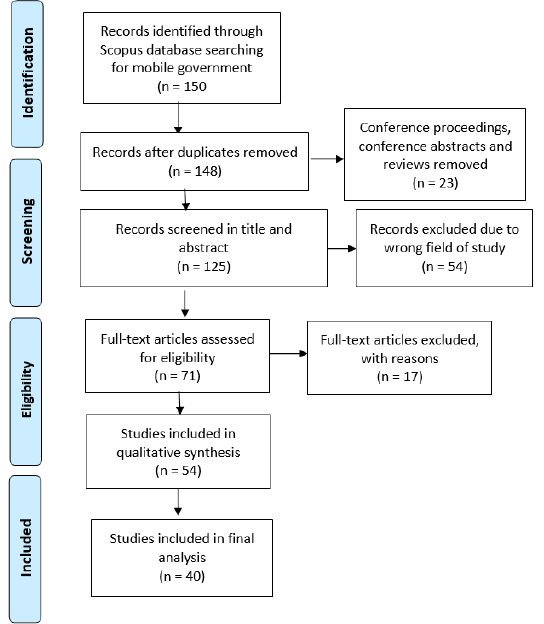
Fig. 1. Literature search and screening process using PRISMA flowchart (Moher et al.,